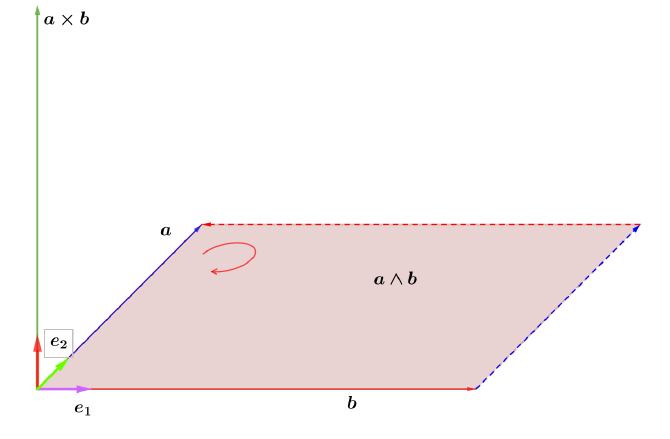
Figure 2. Representation of a bivector a ∧ b